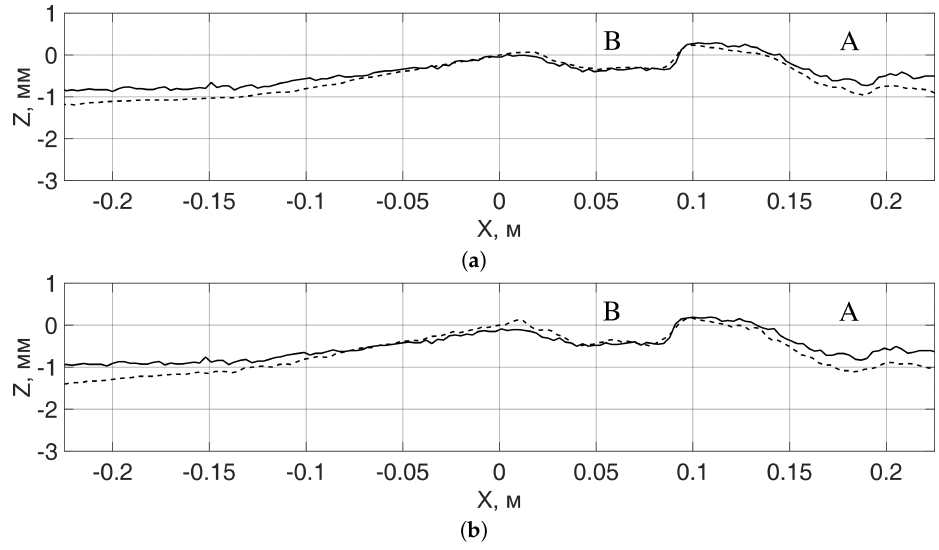
Figure 8. Comparison of contact (solid line) and radar measurements (dashed line) of the surface profile of the rail fragment #2 in the middle line along the rail head: ( a ) both directions of transmit and receive polarizations are along the rail; ( b ) the direction of the transmit polarization is across the rail, the direction of the receive polarization is along the